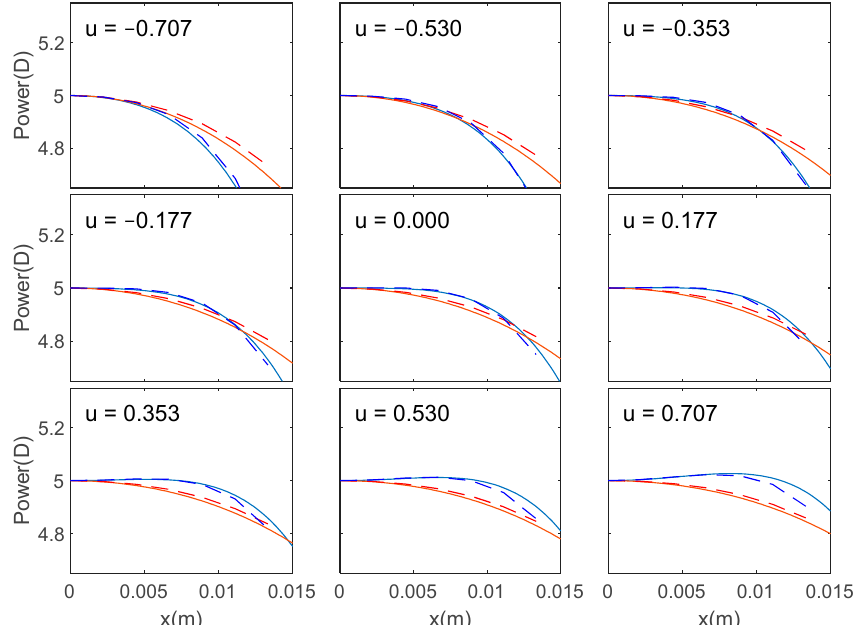
Figure 5. Tangential (blue line) and sagittal (red line) powers up to term c 4 for a lens with P = 5 D, B = 6 D, n = 1.5, and L (cid:48) = 37 D, for 𝑢 ranging from −0.707 to +0.707 . The continuous line represents the analytical solution obtained within the approximation described in the text, while the dashed line corresponds to the numerical solution obtained by optimization.